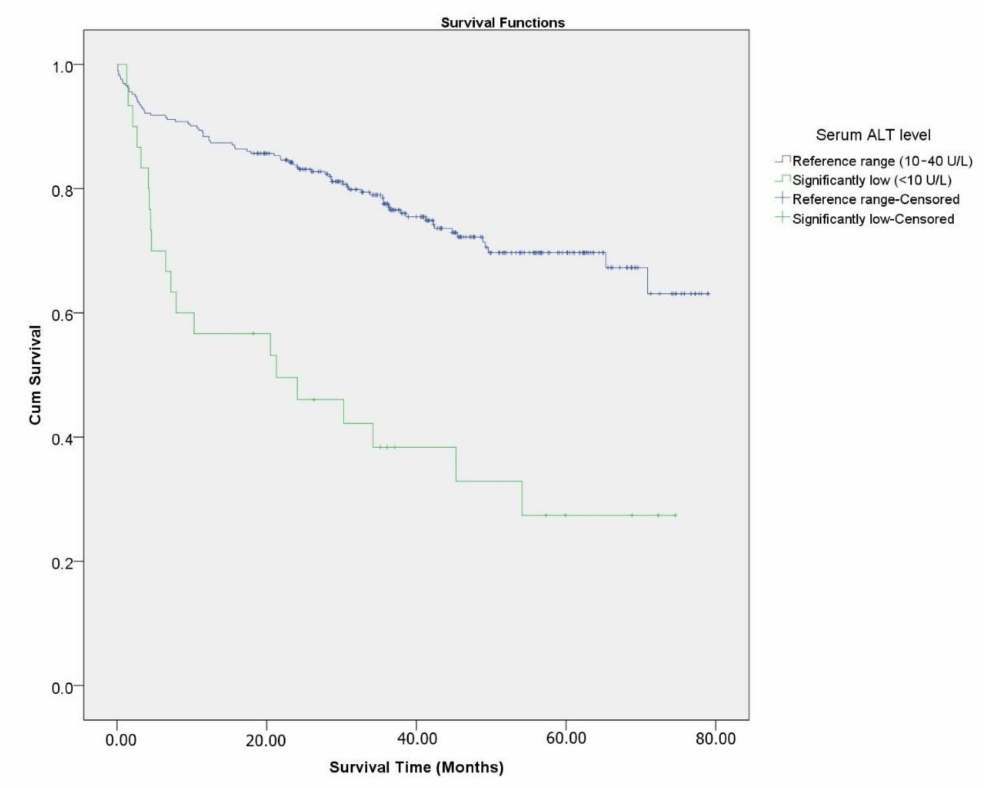
Figure 2. Kaplan–Meier survival function of patients after ischemic stroke. The association between the selected risk factors and all-cause mortality was assessed through univariate analysis (Supplementary Material Table S1). Table 2 shows the unad- justed and adjusted hazard ratio (HR) for all-cause mortality for a significantly reduced ALT level. Elderly patients with ischemic stroke with a significantly reduced ALT